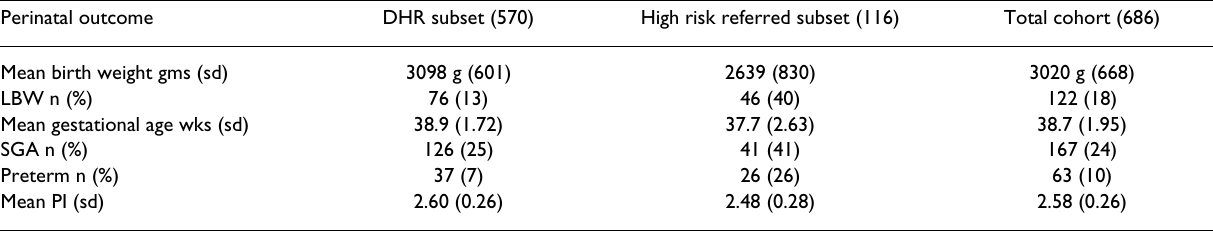
Table 3: Perinatal outcomes. Aboriginal Birth Cohort Study 1987–1990 Perinatal